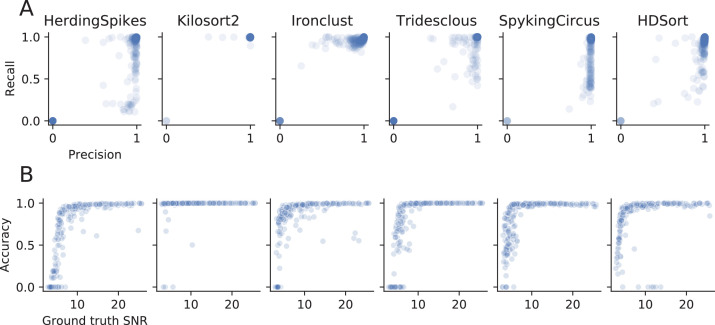
Evaluation of spike sorters performance metrics.(A) Precision versus recall for the ground-truth comparison the simulated dataset. Some sorters seem to favor precision (HerdingSpikes, SpyKING Circus, HDSort), others instead have higher recall (Ironclust) or score well on both measures (Kilosort2). Tridesclous does not show a bias towards precision or recall. (B) Accuracy versus SNR. All the spike sorters (except Kilosort2) show a strong dependence of performance with respect to the SNR of the ground-truth units. Kilosort2, remarkably, is capable of achieving a high accuracy also for low-SNR units.